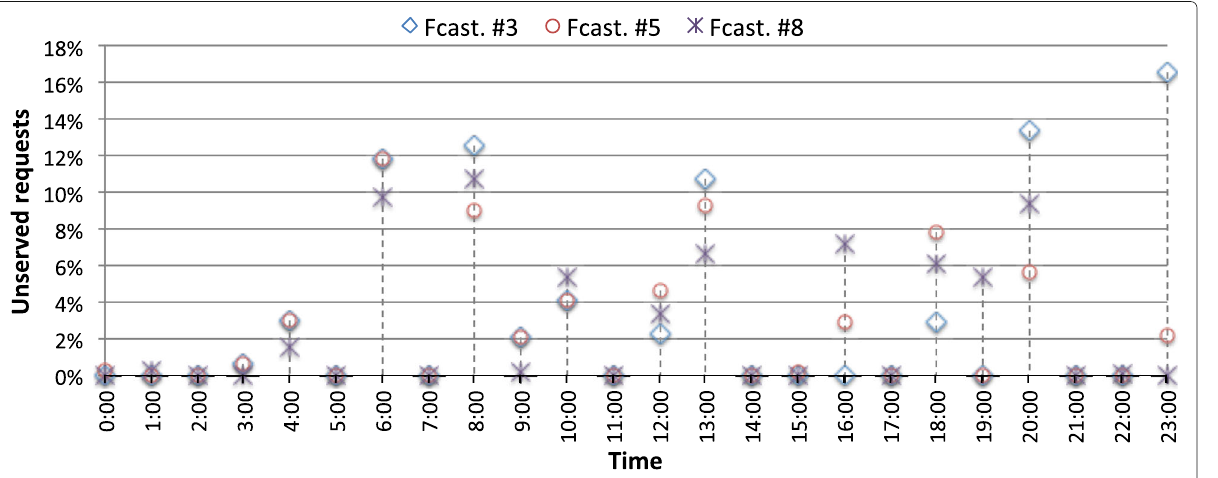
Fig. 9 Percentage of unserved requests for forecasting models #3, #5, and #8, based on the resource allocation of Table 4 This figure shows the percentageofunservedrequestsoneachhourlyperiodforforecastingmodels#3,#5,and#8(inordertoavoidameshofpointsinthegraph,wehave chosen these three cases in representation of the basic models, the polynomial SVM-based models, and the RBF SVM-based models, respectively)